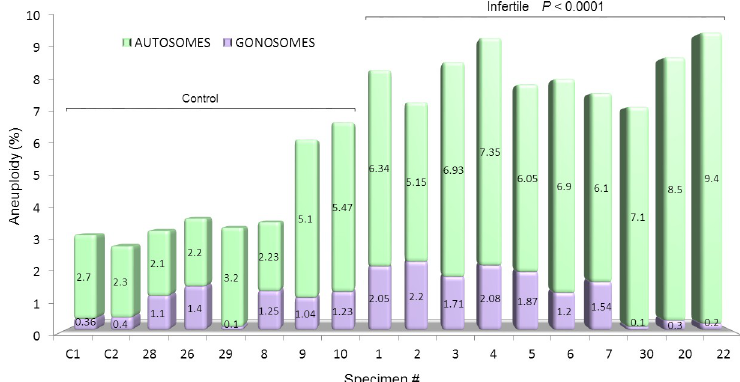
Fig 5. NGS assessment of sperm aneuploidy according to chromosome type in the study population. Both autosomal and gonosomal chromosomes contributed to the overall higher aneuploidy of the infertile cohort in comparison to the fertile control group ( P < 0.0001). The most represented chromosomal defects were related to the autosomes (green portion of the